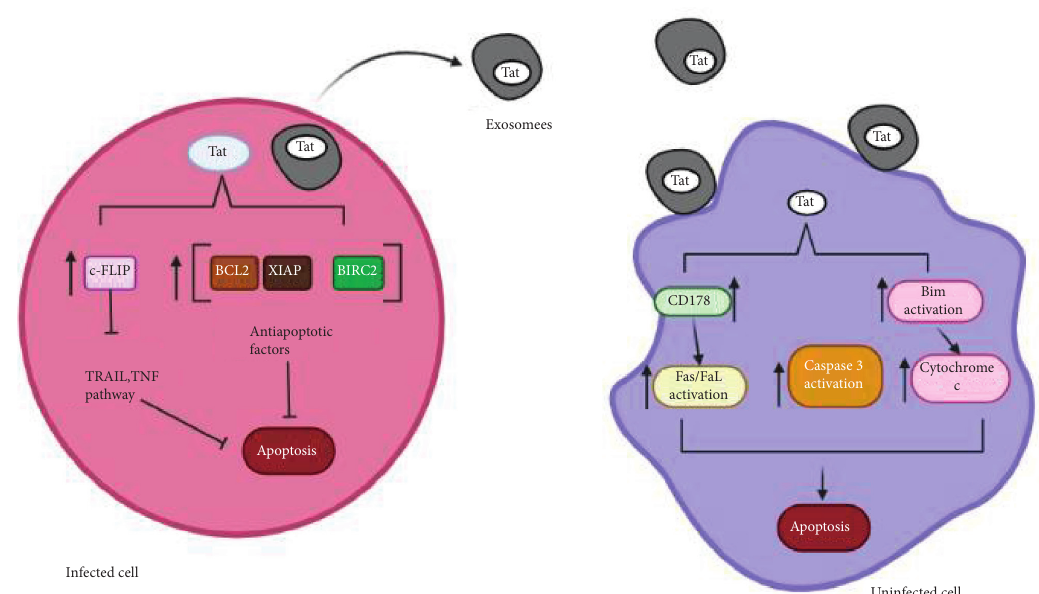
Figure 3: Role of Tat exosomes and secreted Tat in the induction of apoptosis in uninfected